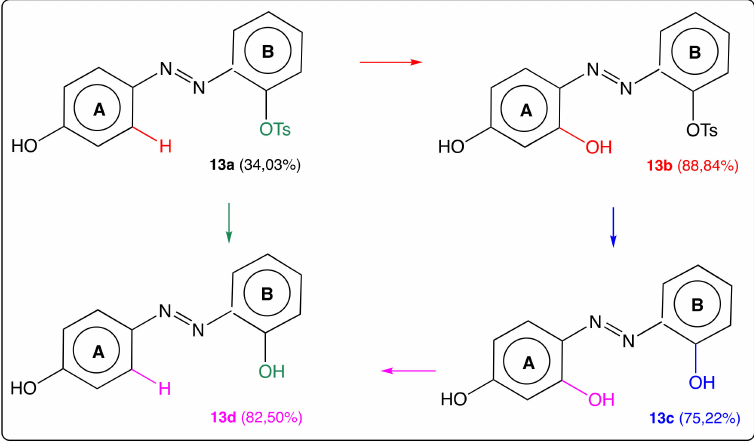
Figure 14. Structure of AZO-ST 13a – d (and percentage of tyrosinase inhibition)